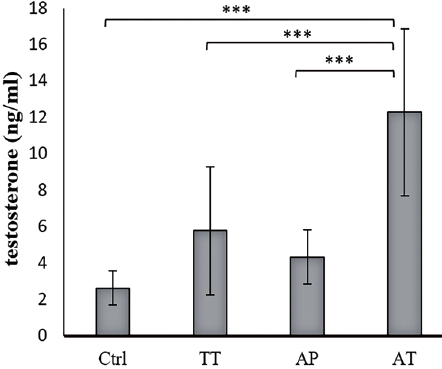
Figure 2- Effect of AP, TT and AT extracts on serum level of testosterone (mean ± SD).